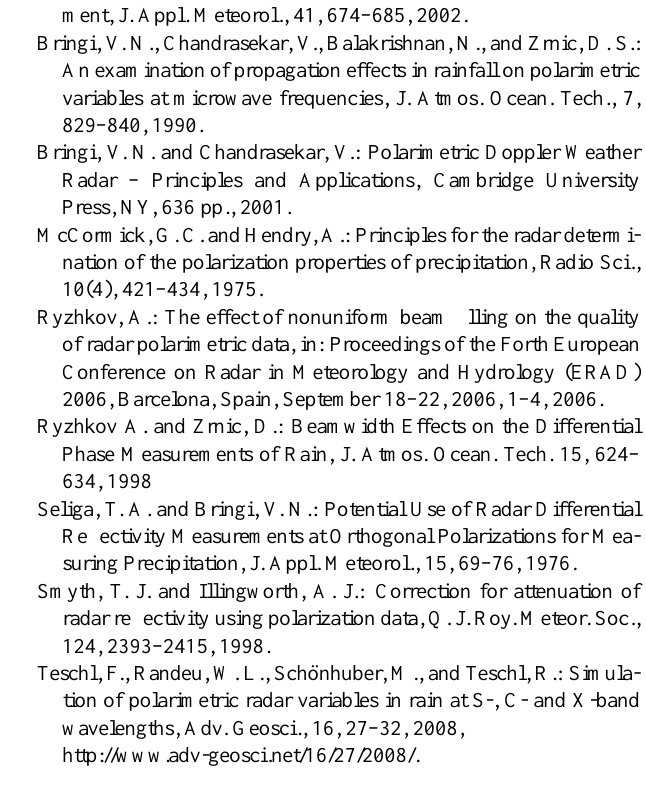
Fig. 7 : Polarimetric variables along a single beam at –0.8° elevation, including filtered PhiDP and attenuation corrected Zh.